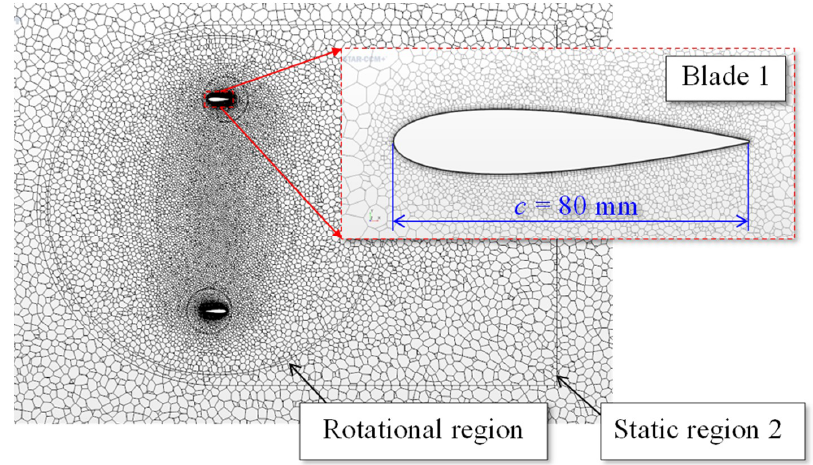
Figure 4. Computational regions around a wind turbine rotor model.